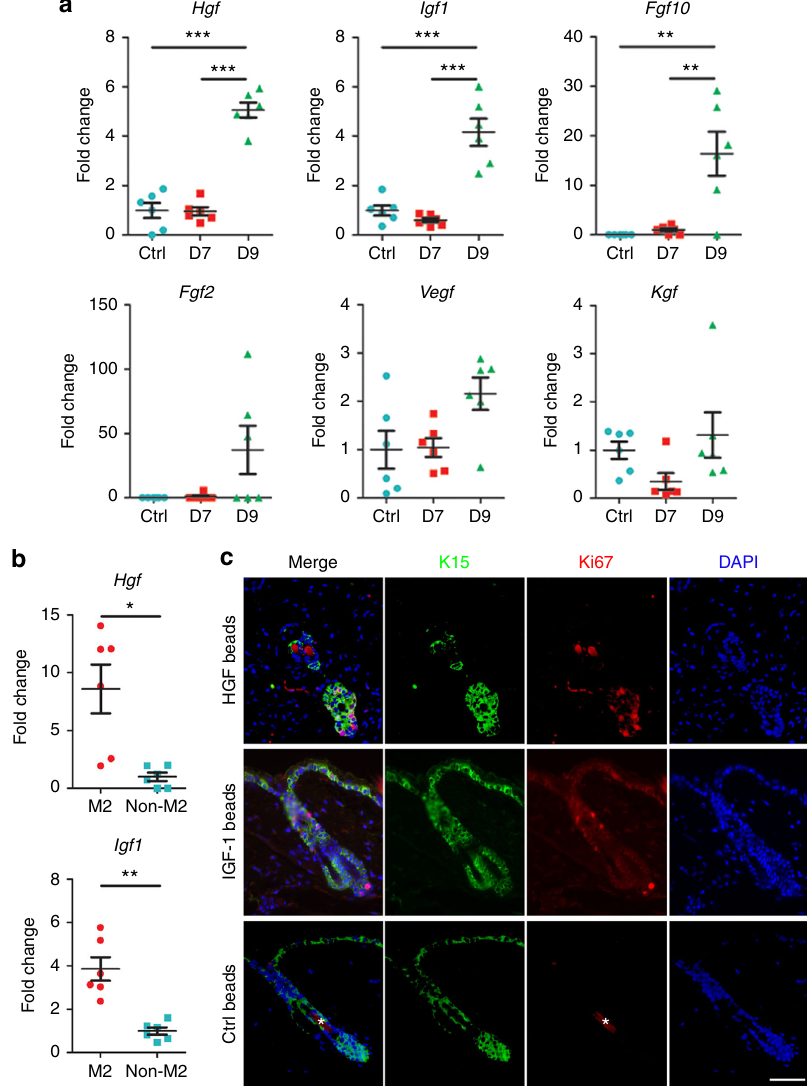
Fig. 6 M2 macrophages produce growth factors to facilitate hair regeneration. a Real-time PCR of the sorted macrophages revealed the kinetics of gene expression of various growth factors in response to stretch (day 7) and release of stretch (day 9); n = 6 for each group. b Expression levels of growth factors within M2 (CD45 + F4/80 + CD206 + ) and non-M2 (CD45 + F4/80 + CD206 - ) macrophages according to real-time PCR; n = 6 for each group. c Dual immunostaining of K15 and Ki67 demonstrated that the injection of HGF-coated or IGF-1- coated beads during the telogen phase precociously activates K15 + hair stem cells. *Auto fl uorescence of hair shafts. Statistical signi fi cance was determined by conducting ANOVA followed by a Bonferroni post hoc test ( a ) or Student ’ s two-tailed t -test ( b ). Data are presented as means± SEM. * p < 0.05. ** p < 0.01. *** p < 0.001. Scale bar = 50 μ m. Source data are